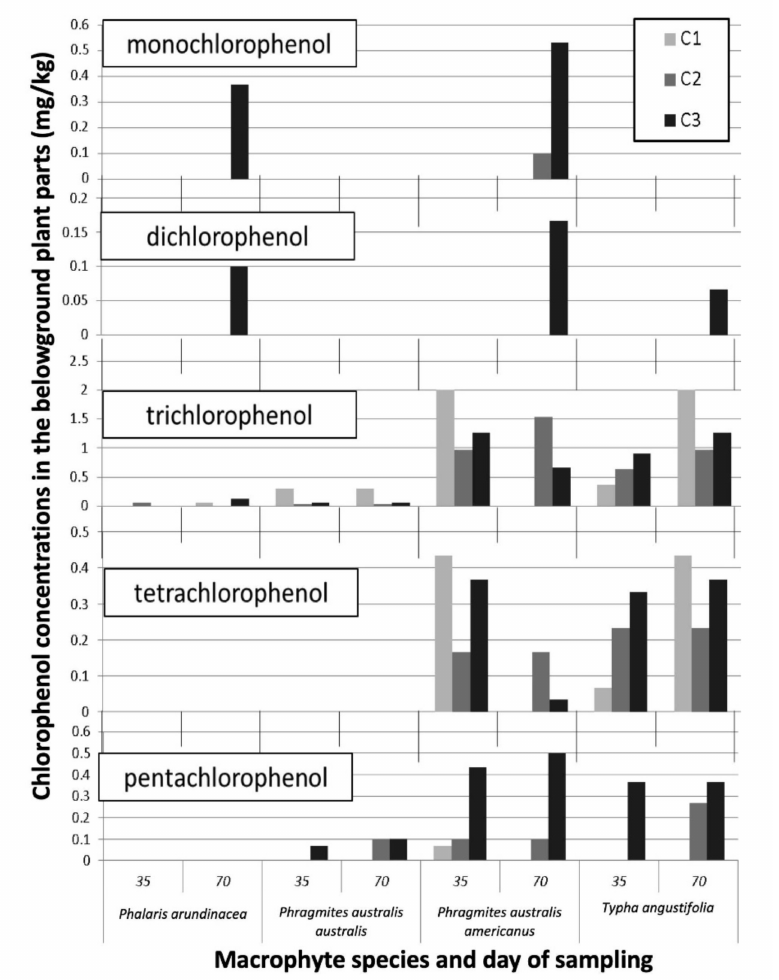
Figure 3. The chlorinated phenol concentrations (mg / kg DW) in the belowground dry biomass of the four macrophyte species exposed to the contaminated leachates (concentrations C1–C3 ) after 35 days and 70 days. No standard errors were calculated, or statistical inferences done due to the large number of samples with undetected levels of